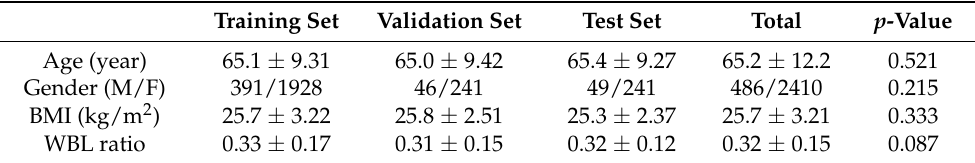
Table 1. Baseline characteristics of the